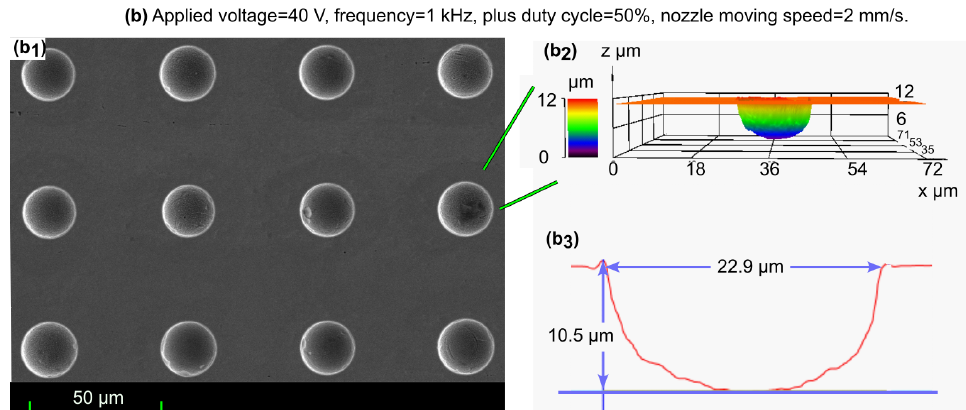
Figure 5. The typical profile of micro cavities at different applied voltage: ( a ): 10V; ( b ): 40V; ( a 1 , b 1 ): SEM images of machined cavities; ( a 2 , b 2 ): Confocal laser scanning microscope images of machined cavities; ( a 3 , b 3 ): Cross-sectional images of corresponding machined cavities.